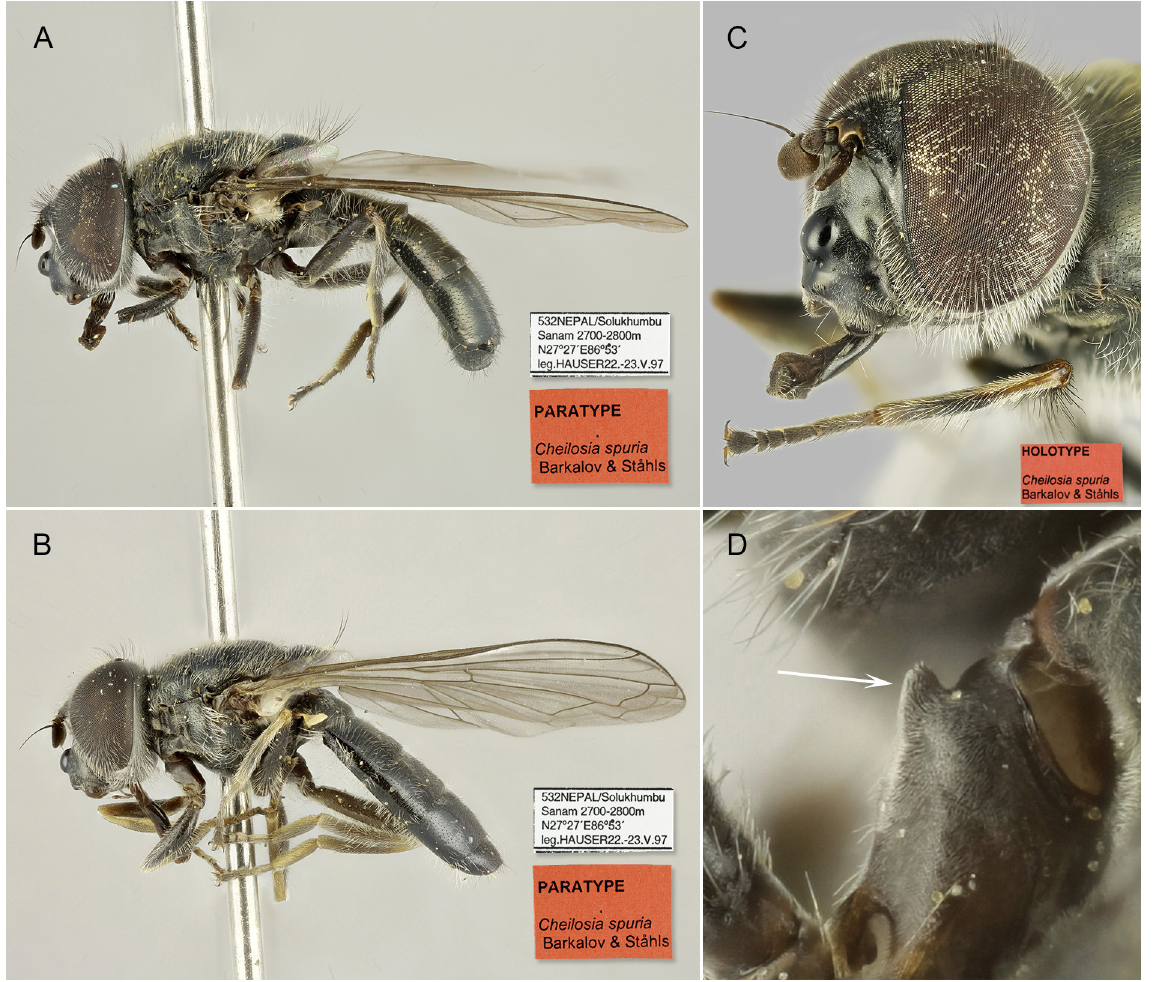
Fig. 61. Cheilosia ( Cheilosia ) spuria sp. nov. A–B . Paratype ♂ and ♀ (CSCA); lateral views. C . Holotype, ♂ (CSCA); head. D . Fore coxa with baso-lateral spur (CSCA). Photo: Pekka Malinen, FMNH Luomus. Scale bars = 1